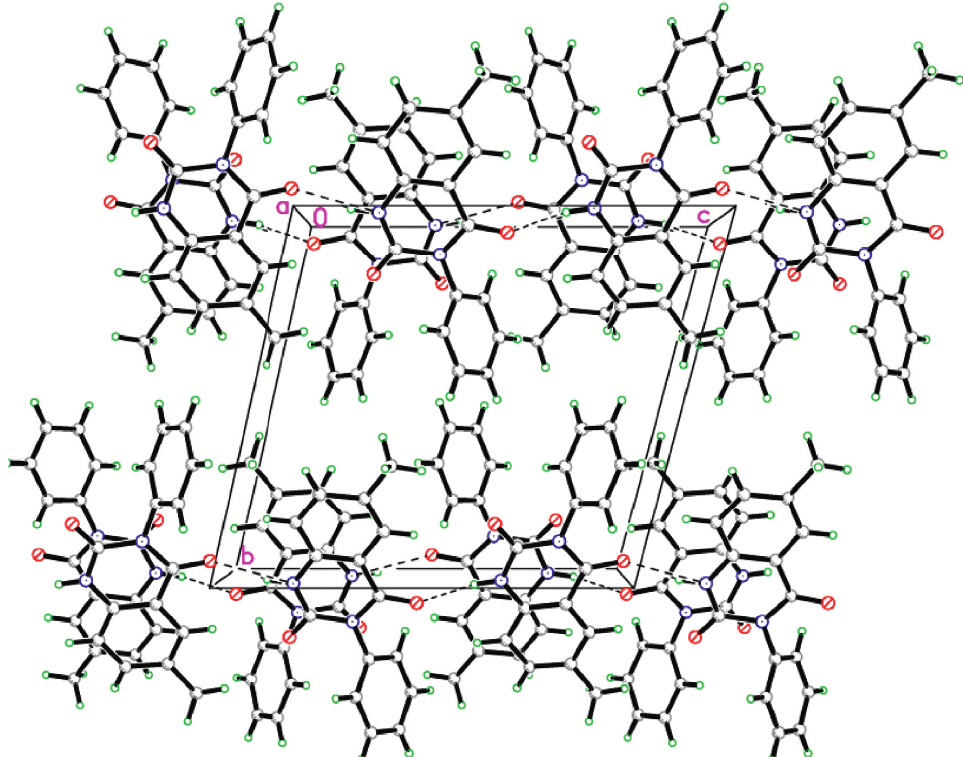
Figure 2: Molecular packing of compound 11 viewed hydrogen bonds which are drawn as dashed lines along the c